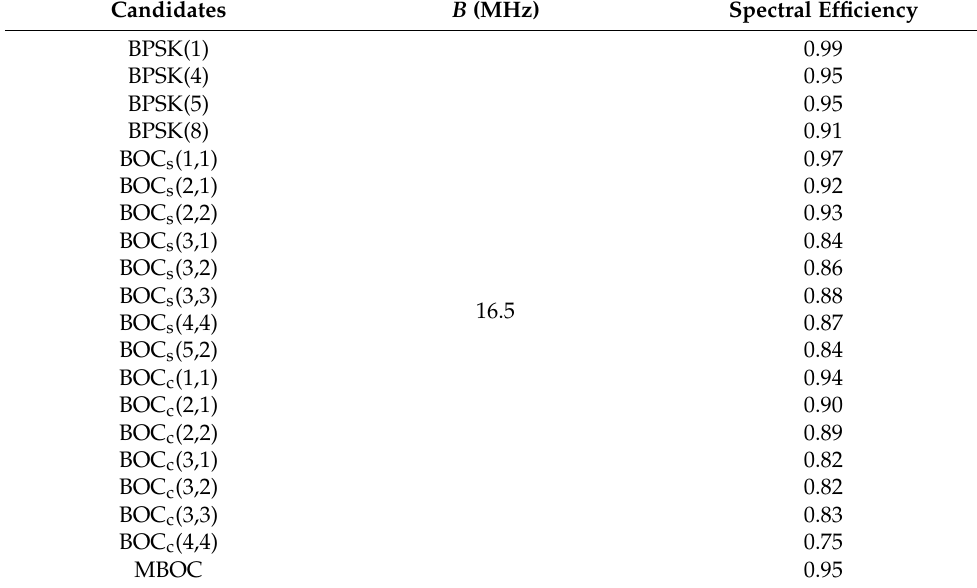
Table 5. Spectral efficiency of candidates in the S-band.